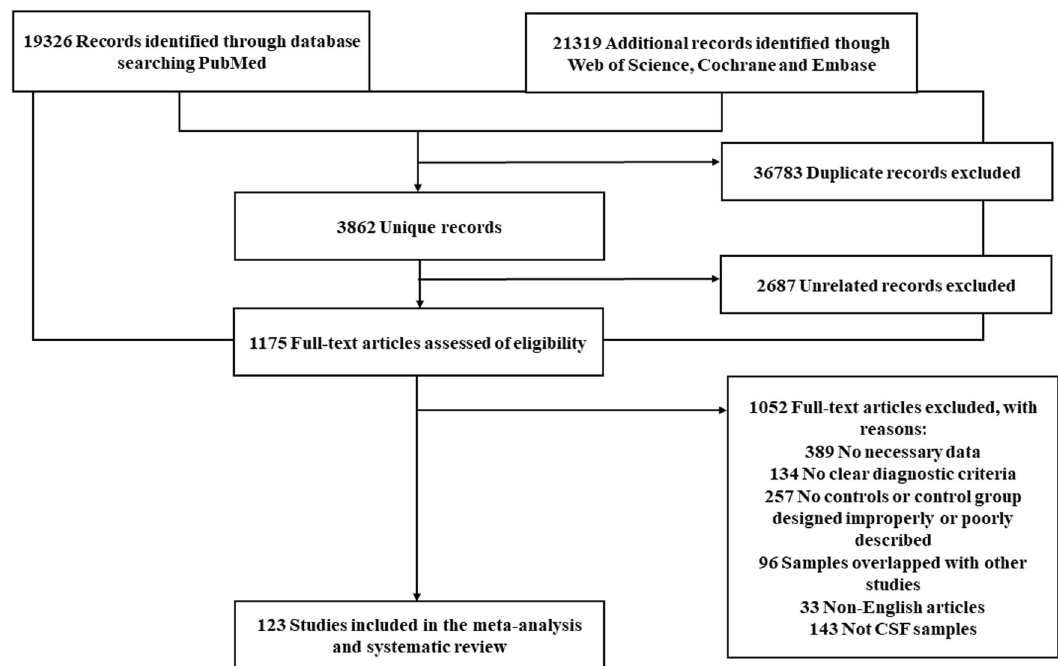
Fig. 1 Flow chart of the systematic article selection strategy. From 19326 studies from Pubmed, and 21319 studies from Science, Cochrane and Embase identi fi ed from the search strategy, a total of 123 articles were included for review. The boxes indicate exclusions of articles during each of the following screening stages: duplicate recoeds, unrelated recos and others. Reasons for exclusion are shown inside the right boxes. The box at bottom indicates inclusion